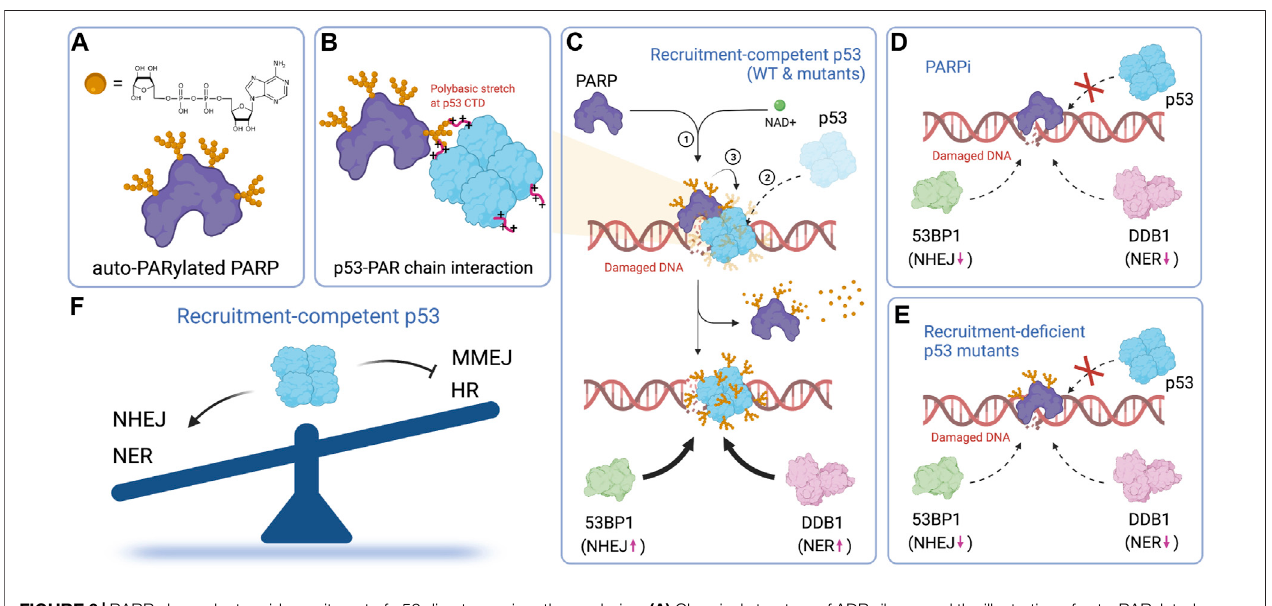
FIGURE 6 | PARP-dependent rapid recruitment of p53 directs repair pathway choice. (A) Chemical structure of ADP-ribose and the illustration of auto-PARylated PARP. (B) p53interactswithauto-PARylatedPARPthroughitsC-terminalpolybasicstretch. (C) Auto-PARylatedPARPdrivestheaccumulationofp53,whichpromotes therecruitmentof53BP1andDDB1andthereforeNHEJandNER,respectively. (D) Therecruitmentofp53,aswellasthesubsequentrecruitmentof53BP1andDDB1, issuppressedbyaPARPinhibitor. (E) Mutationsthatimpair p53rapidrecruitmentalsosuppressrecruitmentof53BP1and DDB1. (F) Earlyrecruitmentofp53tips the balance of repair pathway selection in favor of the NHEJ and NER repair pathway in a transcription-independent fashion. Figures created with BioRender.com.